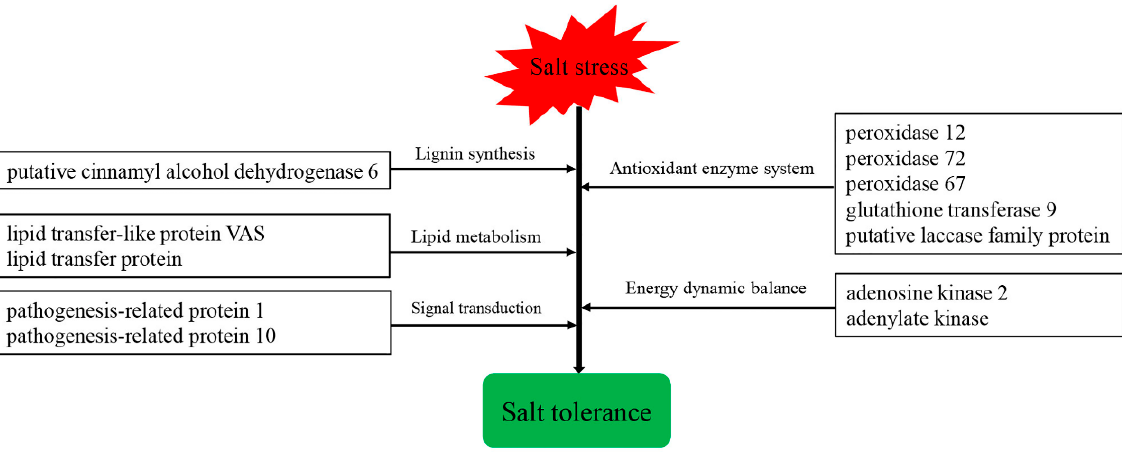
Figure 5. Molecular model of the salt tolerance mechanisms of maize seedling roots.